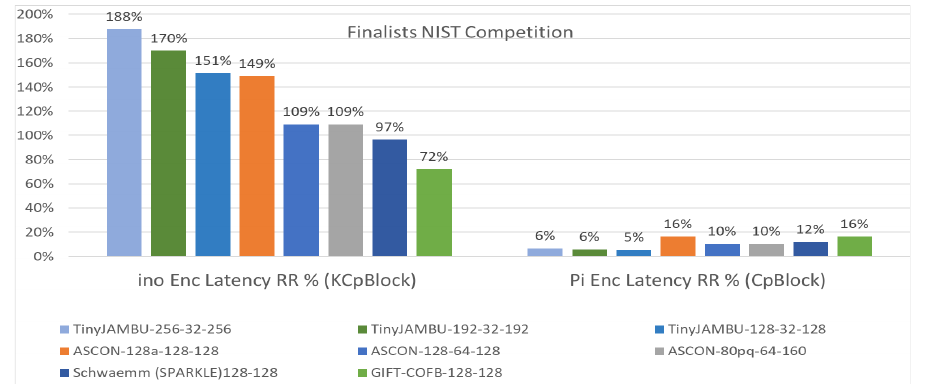
Figure 27. Best 8 Algorithms of NIST finalists in ENC speed latency with respect to RR % for both UNO and